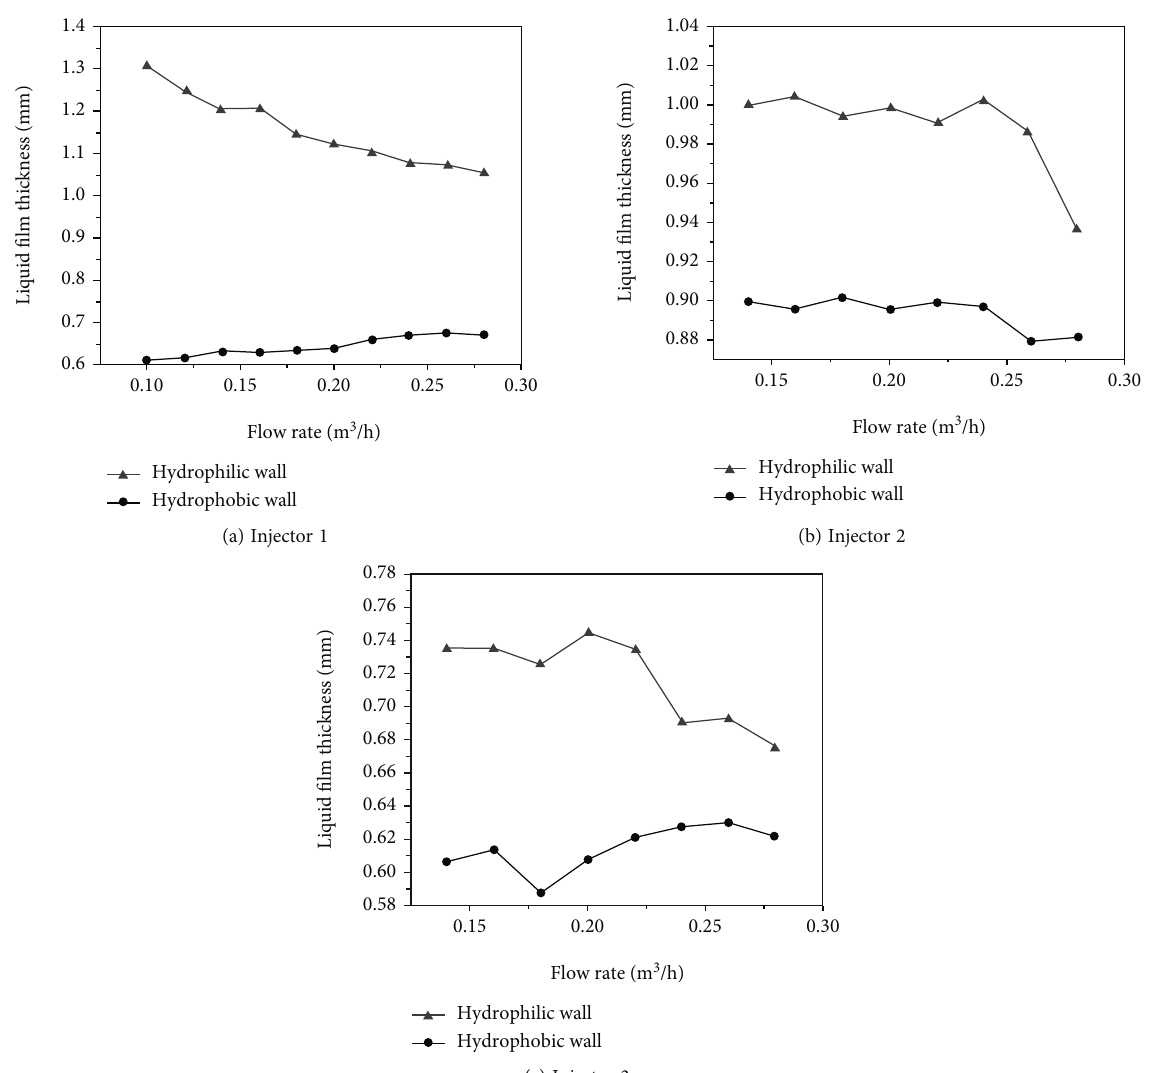
Figure 6: E ff ect of the fl ow rate on liquid fi lm thickness in di ff erent